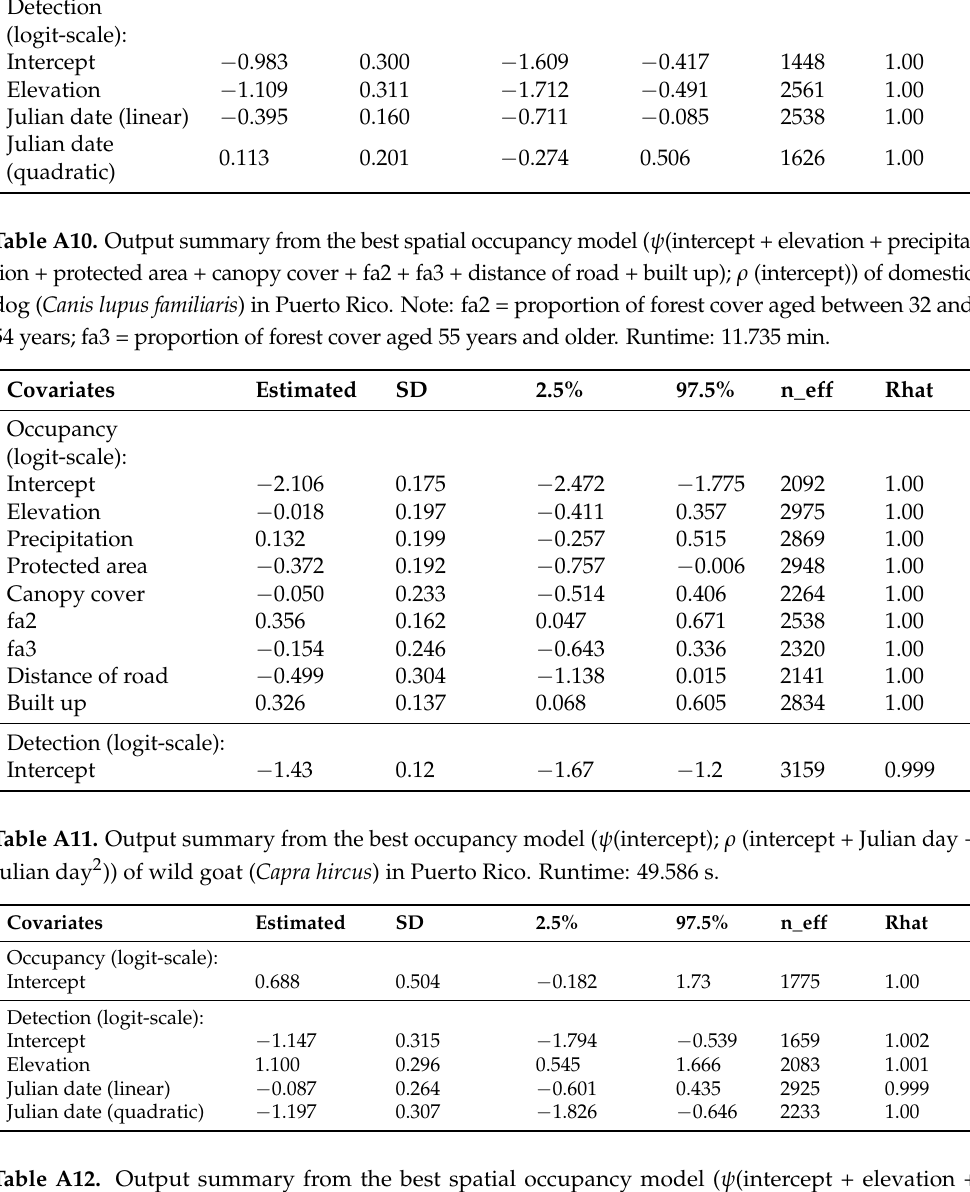
Table A12. Output summary from the best spatial occupancy model ( ψ (intercept + elevation